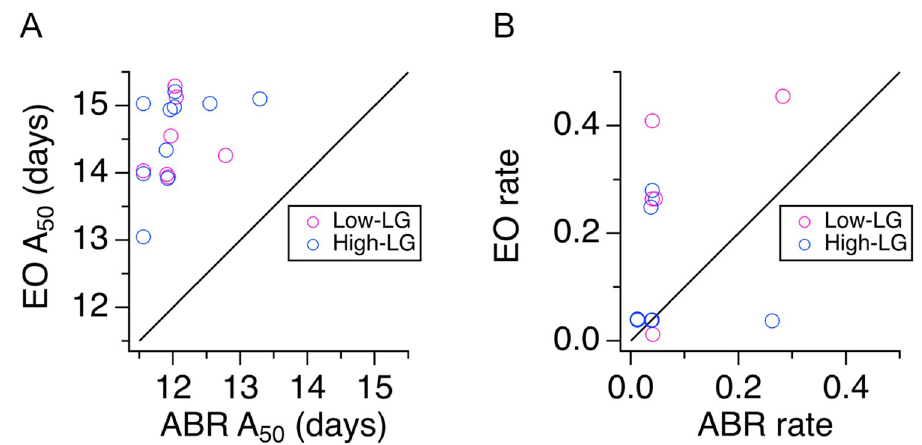
Fig 4. Delay between auditory brainstem response (ABR) onset and eye opening (EO). A , Scatter plot of A 50 values shows the relationship between EO and ABR onset in low licking and grooming (low-LG) and high licking and grooming (high-LG) litters. B , Scatter plot of rate coefficient k values shows the relationship between EO and ABR development in selected low-LG and high-LG litters. Magenta symbols represent low-LG data; blue symbols represent high-LG data. Black line in A and B represents the identity